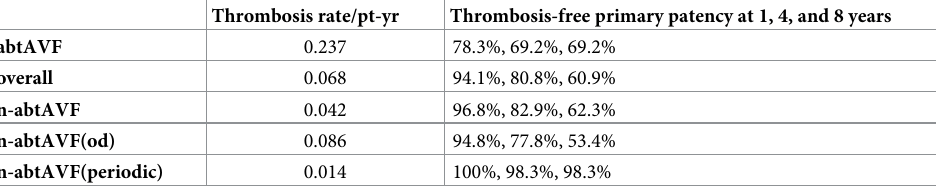
Table 3. The thrombosis rate and thrombosis-free primary patency of the target follow-up groups. Thrombosis